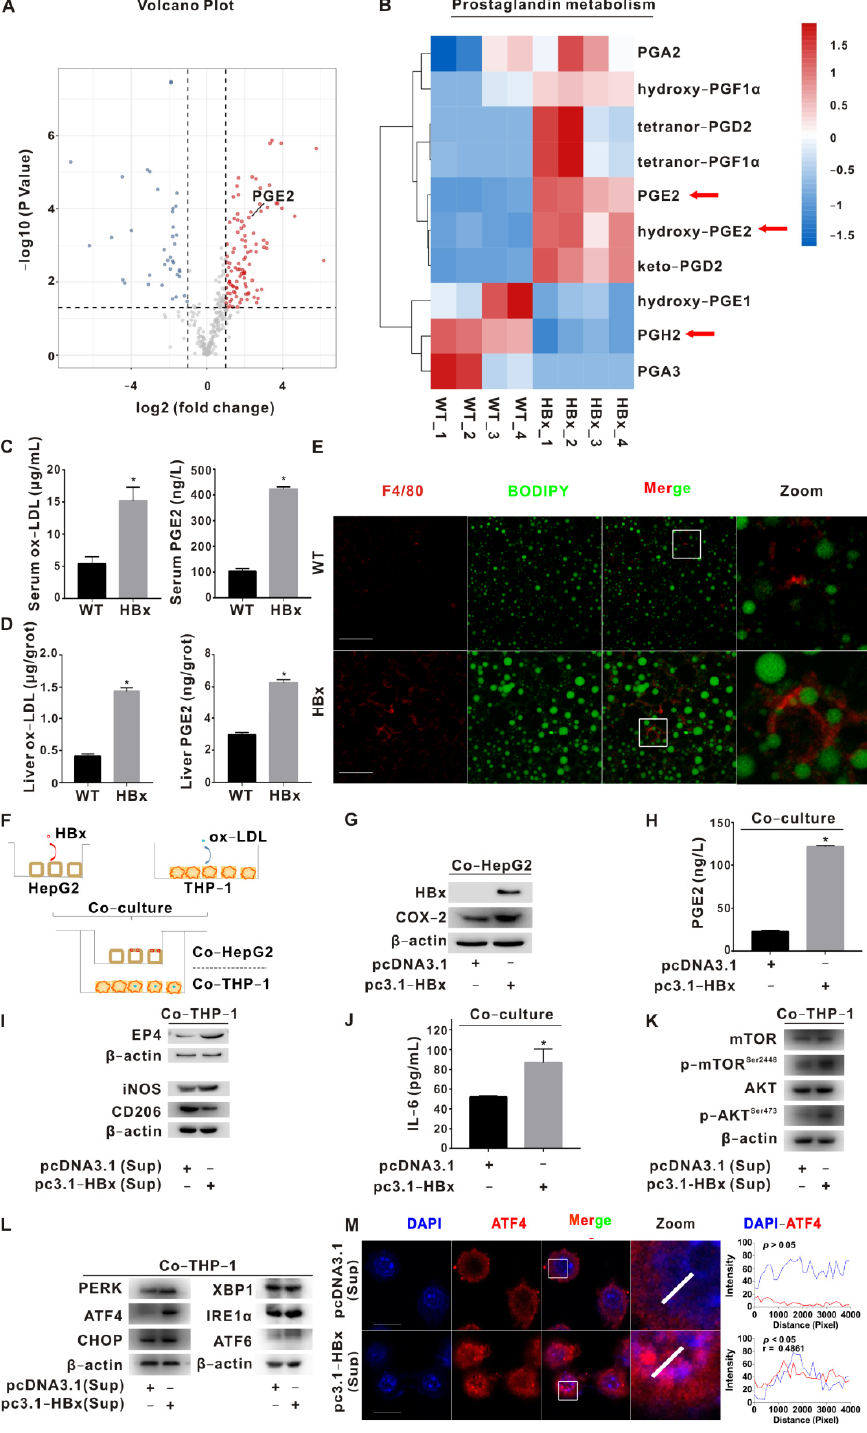
Figure 1. PGE2-EP4 induced ER stress-mediated macrophage polarization imbalance via mTOR signaling. ( A , B ) Untargeted metabolomic analysis of livers from HBx-Tg mice. ( A ) The volcano plot of differentially metabolites presents red points for upregulated metabolites ( n = 104) and blue points for downregulated metabolites ( n = 35). The increased level of PGE2 is shown. ( B ) The